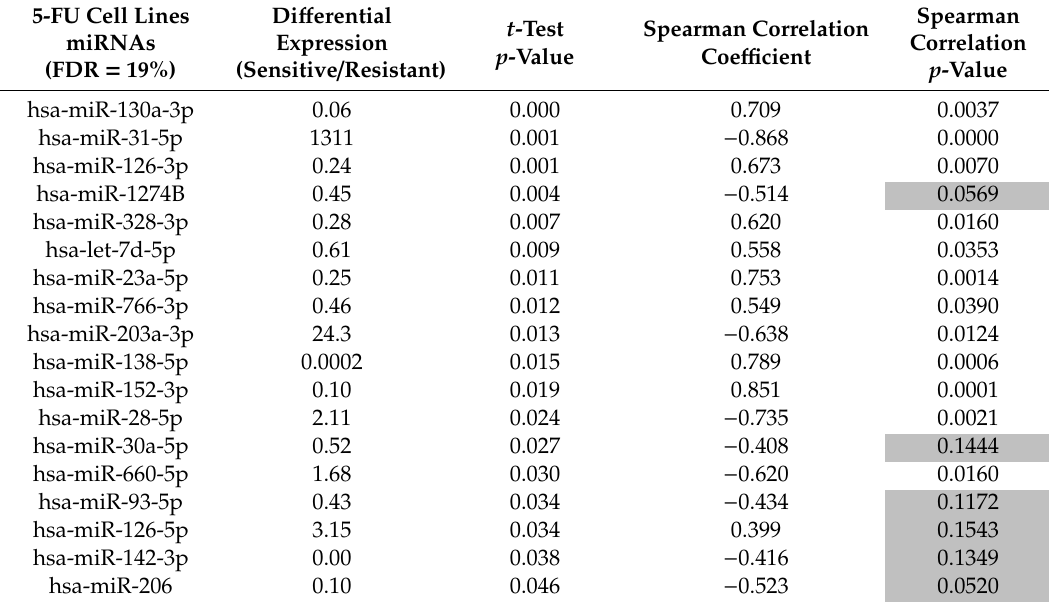
Table 3. miRNAs that were associated with treatment response to 5-FU in OAC cell lines. Significant treatment response was measured as (i) di ff erential expression between cell lines that had low vs. high survival fractions, and (ii) non-parametric correlation of expression levels with survival fractions across all cell lines. miRNAs with Spearman correlation p -values > 0.05 are highlighted in grey.